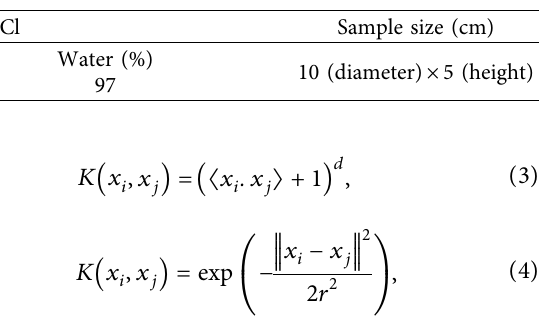
Table 7: Te usage rate of